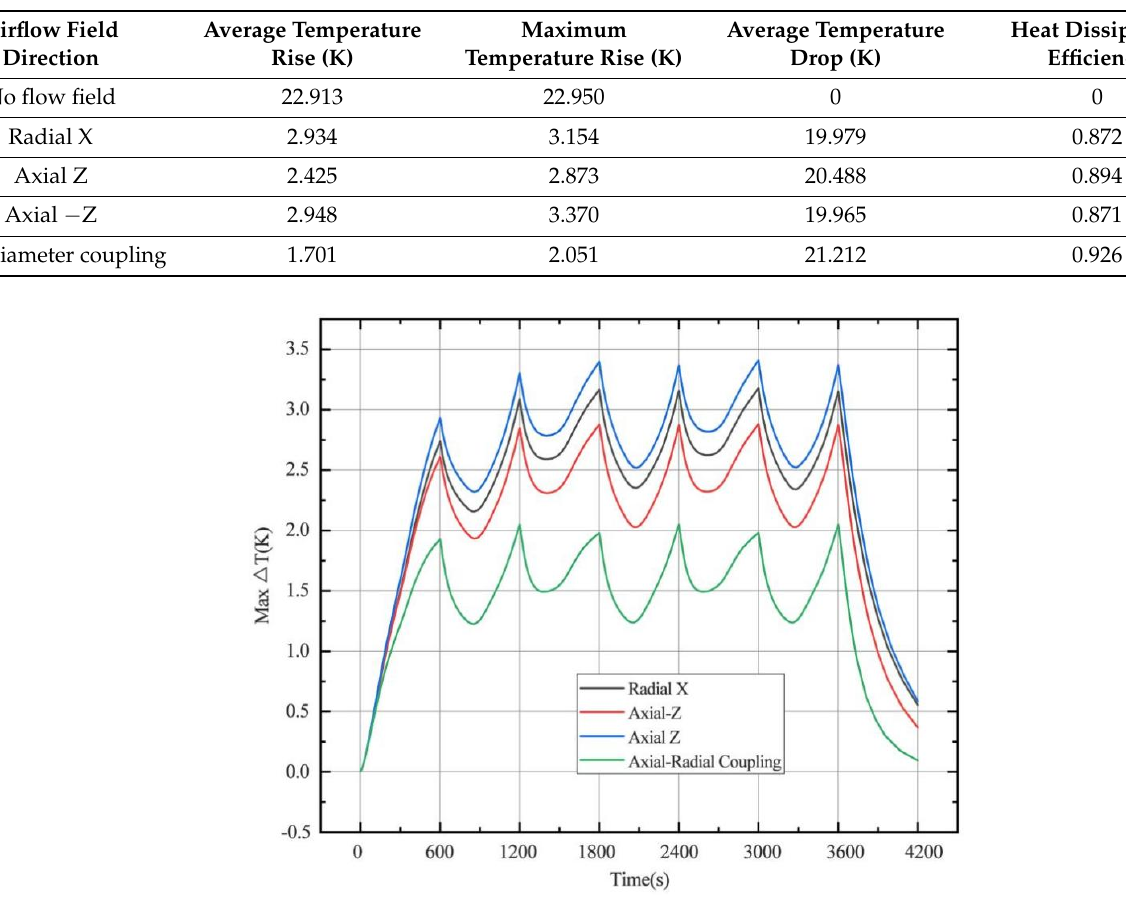
Figure 16. The e ffect of airflow field direction on the maximum temperature rise of the battery. Figure 16. The effect of airflow field direction on the maximum temperature rise of the